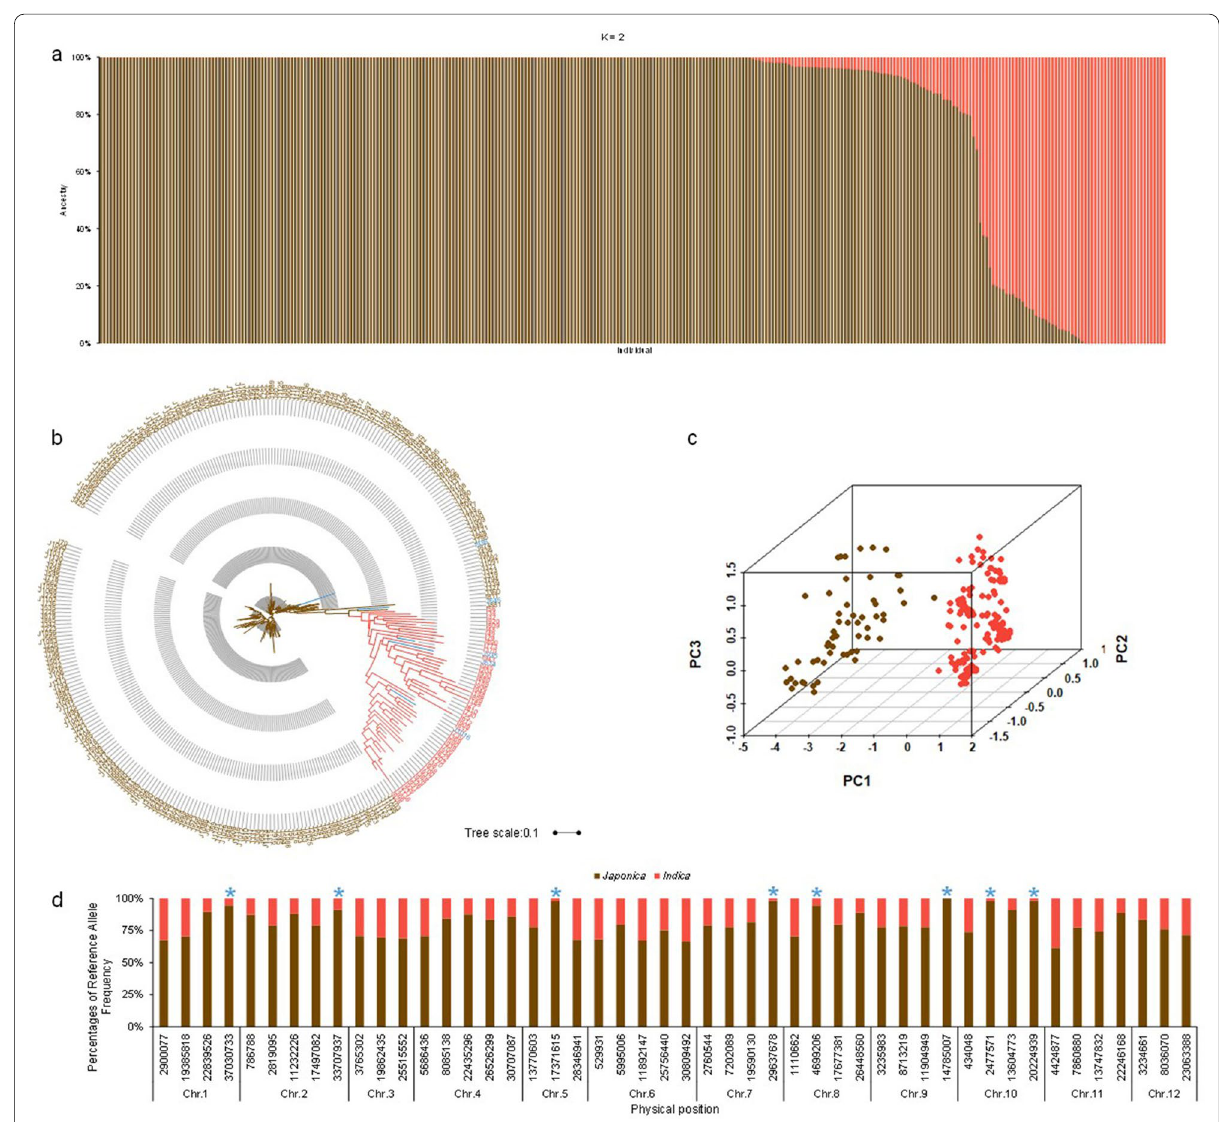
Fig. 4 Analysis of the 48 KASP markers in conventional varieties. a – c The phylogenetic tree, population structure and PCA of the conventional varieties using 48 KASP markers. d The difference of reference allele frequency between japonica and indica . The blue star indicated the sites which showed almost completely different alleles. The brown indicated the japonica varieties while light red represented the indica varieties in b . The blue indicated that the varieties with the classification of the phylogenetic tree different from the original annotation coming from the breeding institutes in b . The brown indicated the subpopulation 1 while light red represented subpopulation 2 in